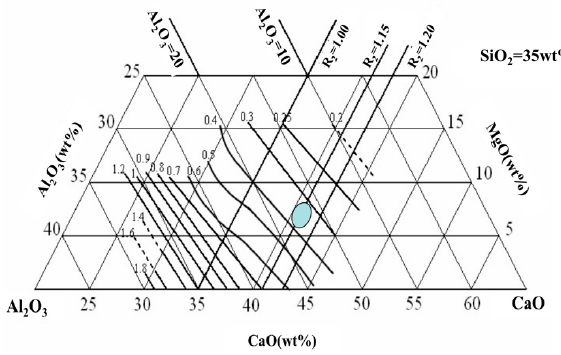
Figure 2. Isoviscosity diagram of the CaO–SiO 2 –Al 2 O 3 –MgO quaternary slag system (1500 °C, Pas) [1].